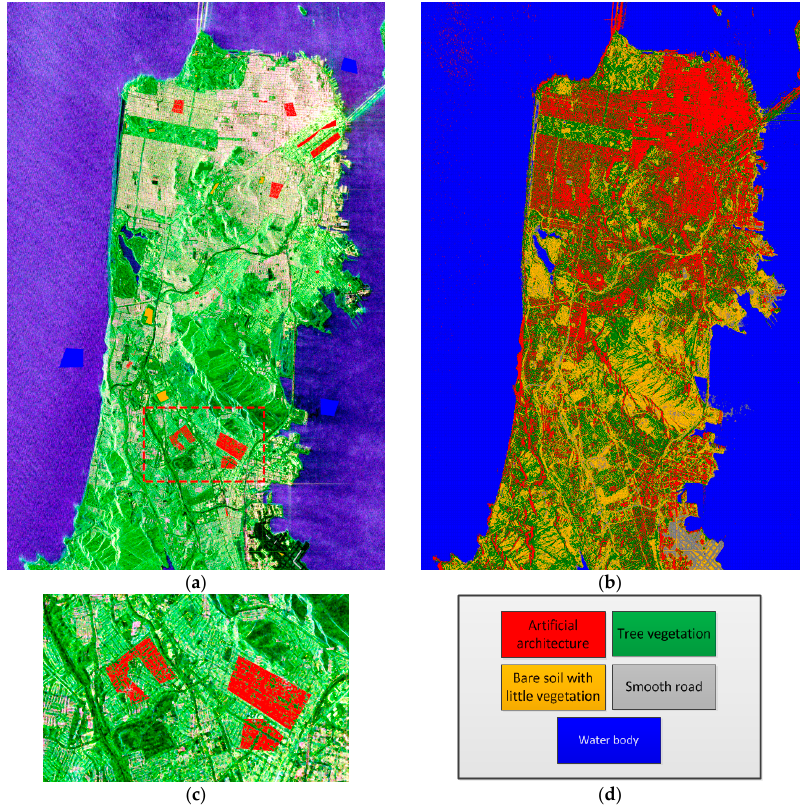
Figure 6. ( a ) Roughly selected samples; ( b ) The result obtained using the Fast Wishart classifier without iteration; ( c ) The area with red boundary in (a), which shows how to eliminate the incorrect samples by setting a threshold to span ; ( d ) The label colors of the five categories.